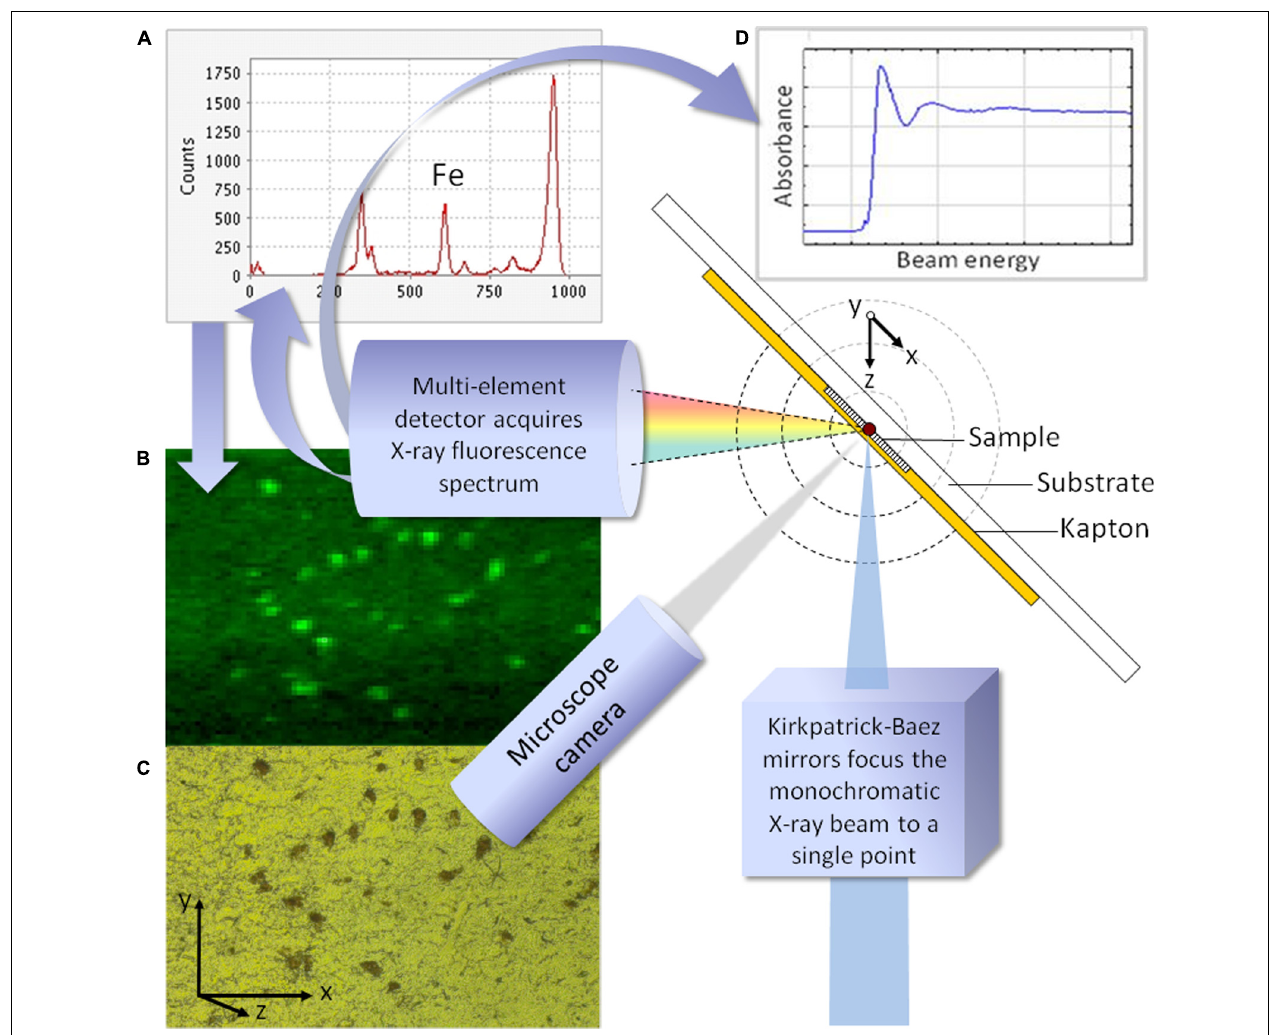
element specific maps. Panel (B) shows the iron map for the region of pigmented substantia nigra shown, corresponding to the region viewed via the microscope camera (C) .To obtain the X-ray absorption spectrum from a point of interest in the sample, shown in panel (D) , the beam energy is varied and the XANES spectrum